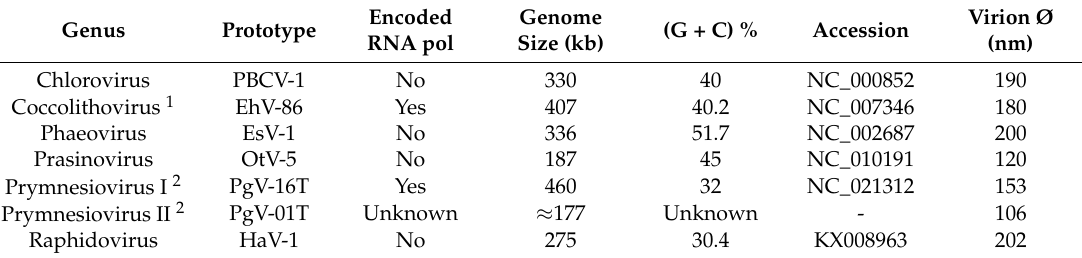
Table 2. Structure of the Phycodnaviridae family as presently recognized by